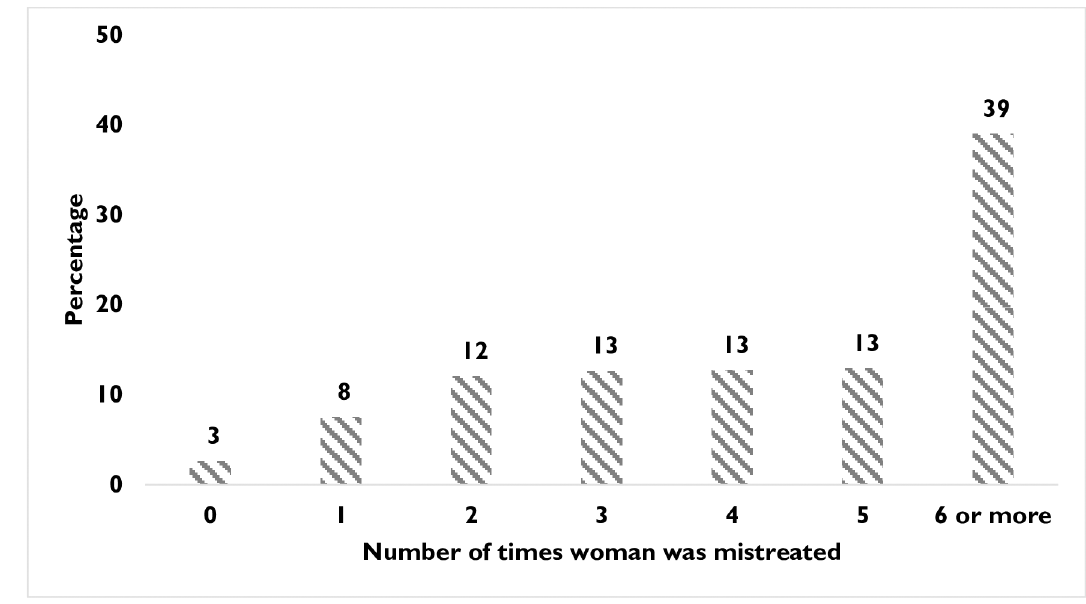
Fig 2. Prevalence of mistreatment care during